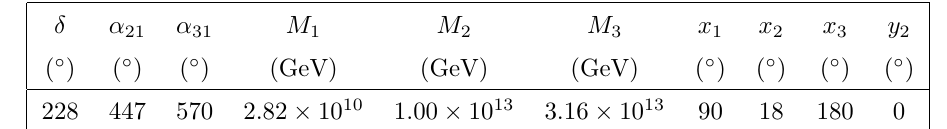
Table 2 . A benchmark point for leptogenesis with M 1 = 2 : 82